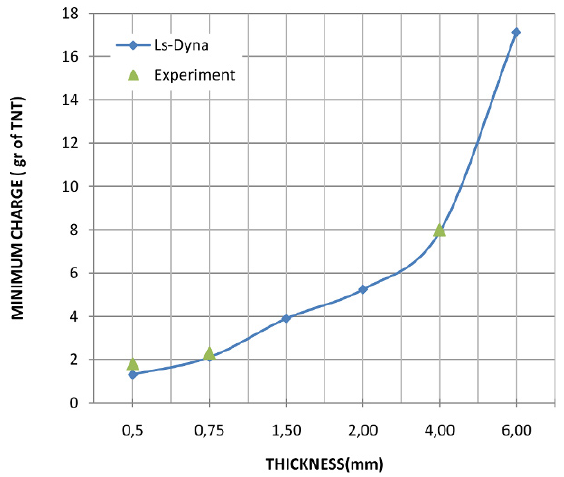
Figure 14. Comparison between the minimum simulated and experi- mental charges for 300 mm diameter.